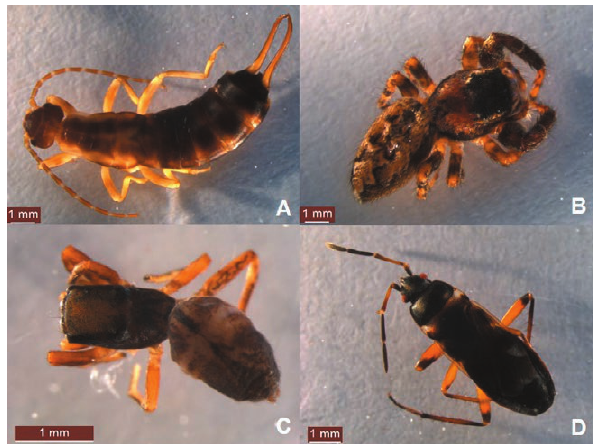
Figure 3. Most commonly found arthropods in cardboard-traps mounted to grapevine trunks in two vineyards: A, Forficula auricu- laria L. ( Dermaptera : Forficulidae ); B, Marpissa muscosa Clerck ( Ara- nea : Salticidae ); C, Synageles venator Lucas ( Aranea : Salticidae ); and D, Raglius alboacuminatus Goeze ( Heteroptera : Rhyparochromidae